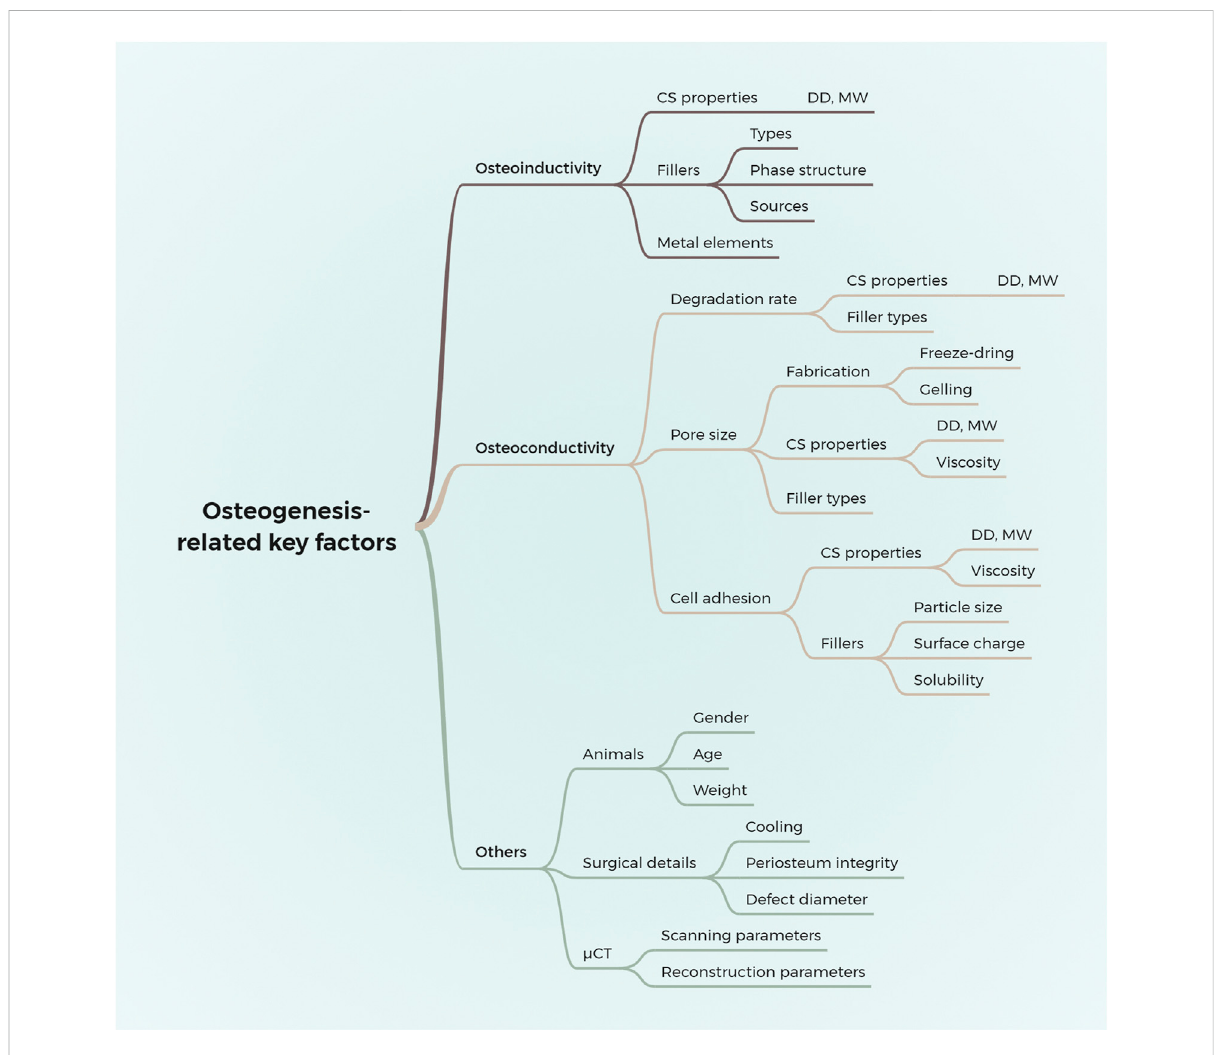
FIGURE 5 Summaryofthekeyfactorsthatin fl uencetheeffectsofchitosan/inorganicnanomaterialscaffoldsonosteogenesisincalvariaCSDmodels.DD, the degree of deacetylation; MW, molecular